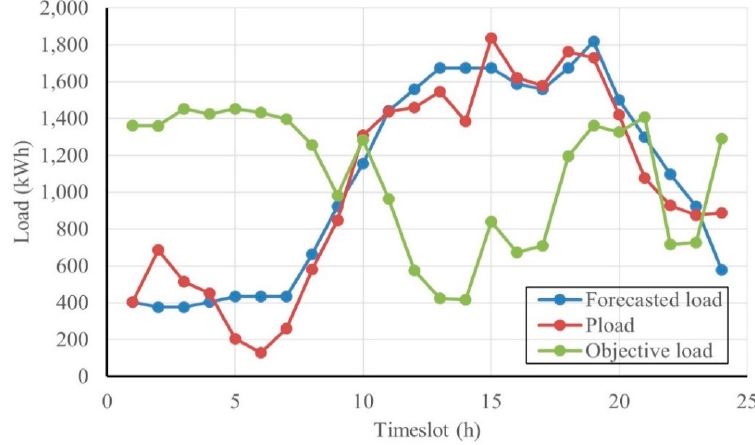
Figure 6. Hourly commercial load before and after shifting using TOU-PSO.